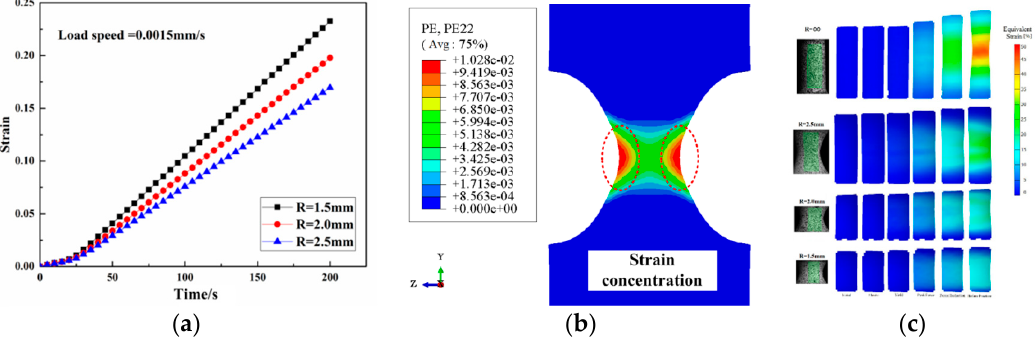
Figure 2. ( a ) Variations of strain at the circumferential area when the same loading speed was applied to the 2618 aluminum alloy; ( b ) strain distribution of specimens with 1.5 mm notch for the 2618 aluminum alloy simulated by the FE model; and ( c ) determination of the strain rates by the DIC